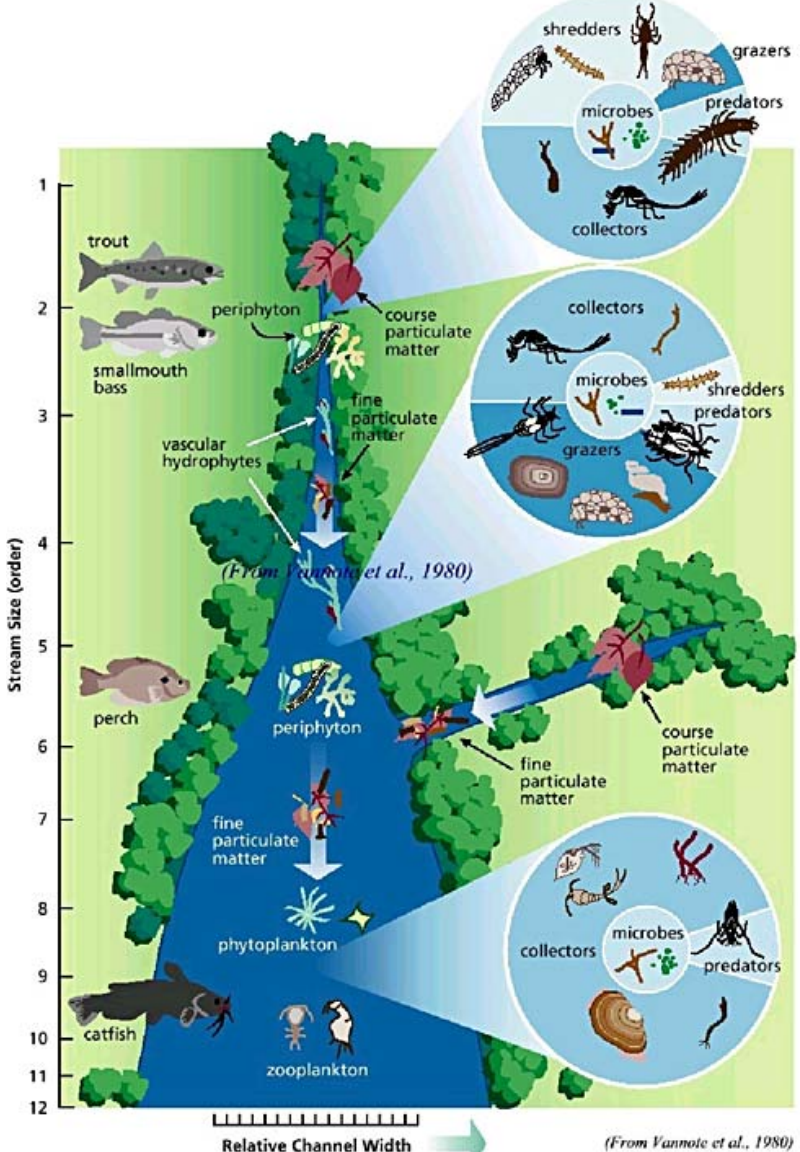
Figure 13. Relationship between stream size and the progressive shift in structural and functional attributes of lotic communities (Adapted from Vannote et al.